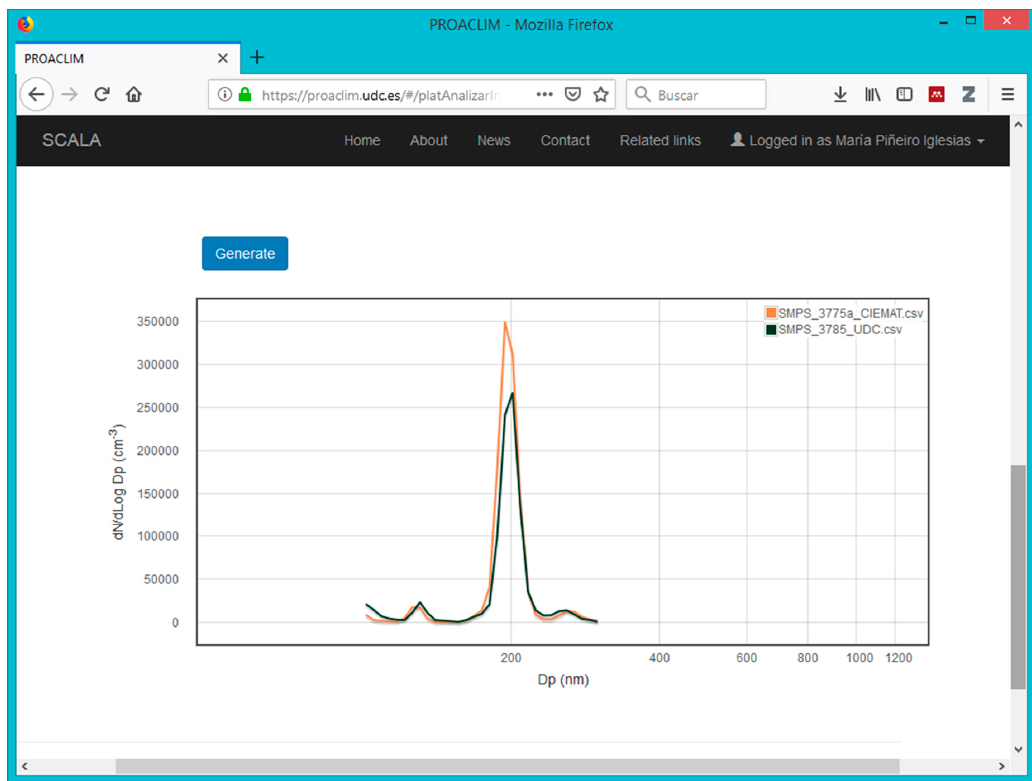
Figure 5. dN/dLog dp (cm − 3 ) vs. dp (nm) for the Scanning Mobility Particle Sizers (SMPS) calibration checks with 200 nm latex particles.